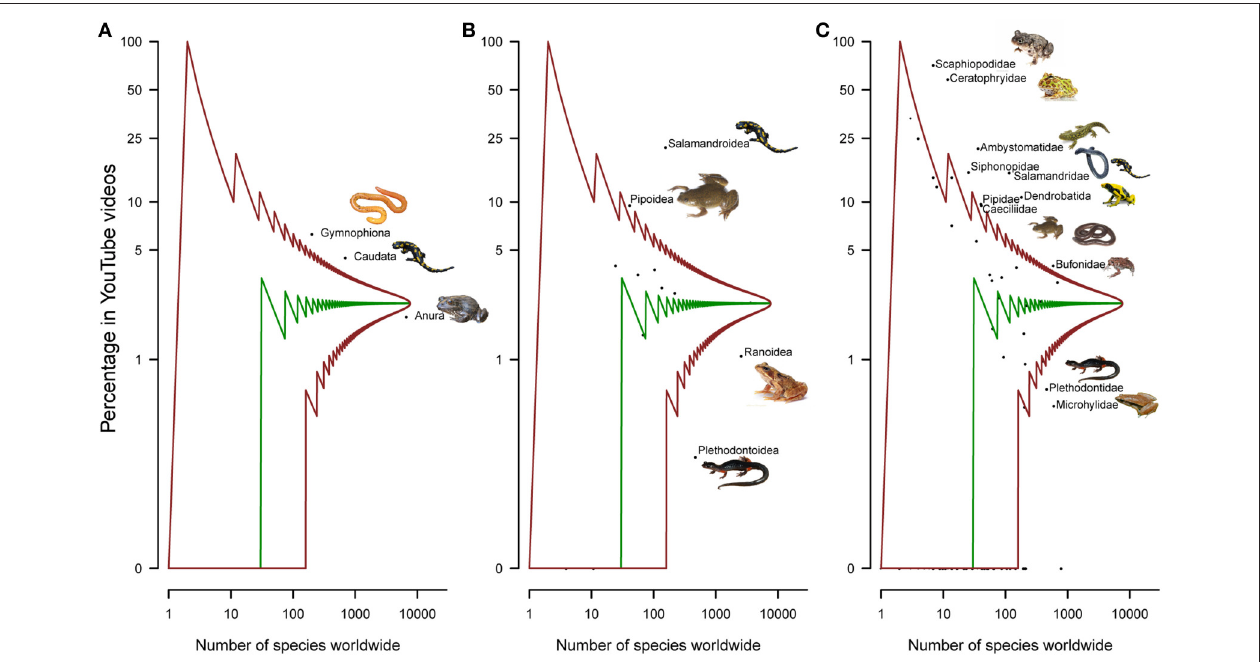
FIGURE 1 | Taxonomic patterns in amphibian (A) orders, (B) superfamilies, and (C) families present in the species identified in captive YouTube amphibian videos. The median (green line) and 95% confidence intervals (brown lines above and below), adjusted for multiple comparisons, were estimated from the hypergeometric distribution. The points that fall between the 95% confidence intervals are not significantly over or under-represented, relative to the number of amphibian species worldwide. Those labeled orders, superfamilies or families that fall above the 95% confidence intervals are over-represented and those below are under-represented in our sample of YouTube